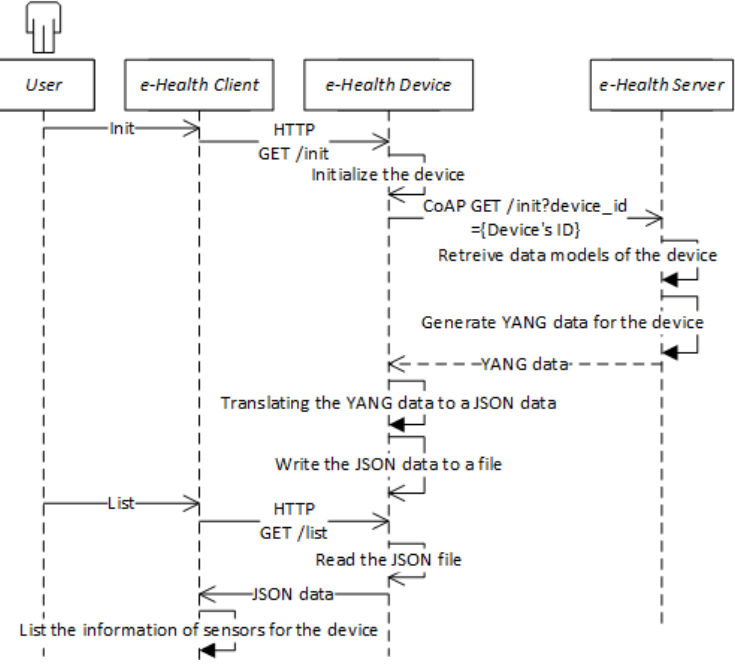
Figure 5. Sequence diagram of the healthcare system for initializing the e-Health device and getting the resource list.